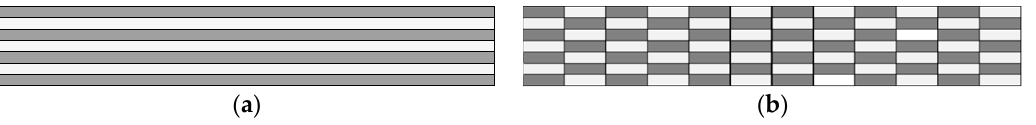
Figure 1. Hybrid configurations: interlayer ( a ) and intralayer ( b ). Dark and light grey fields indicate different types of fibres in the hybrid laminate. Based on [11].